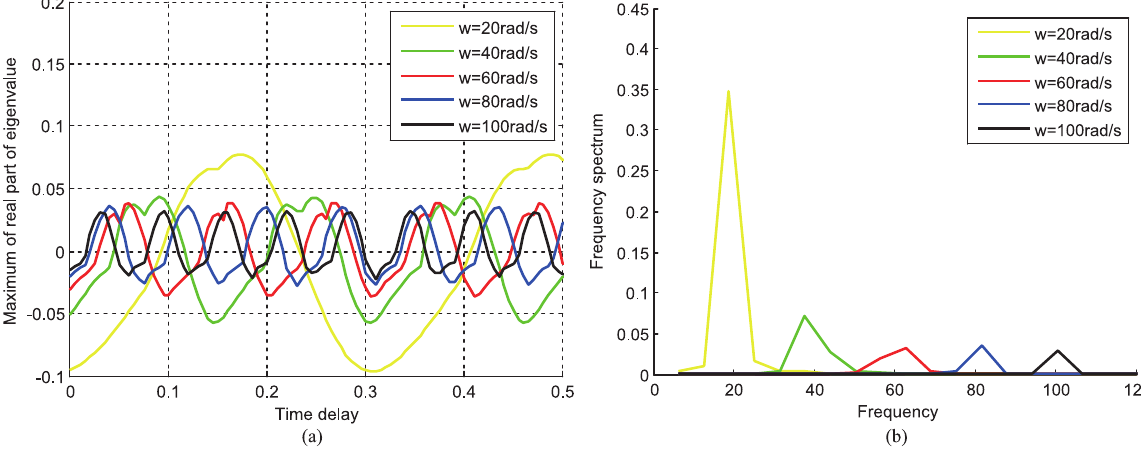
Fig. 9. Effect of time delay on the stability of VDBG DVA, (a) the largest values of the real parts of characteristic roots; (b) frequency spectrum.